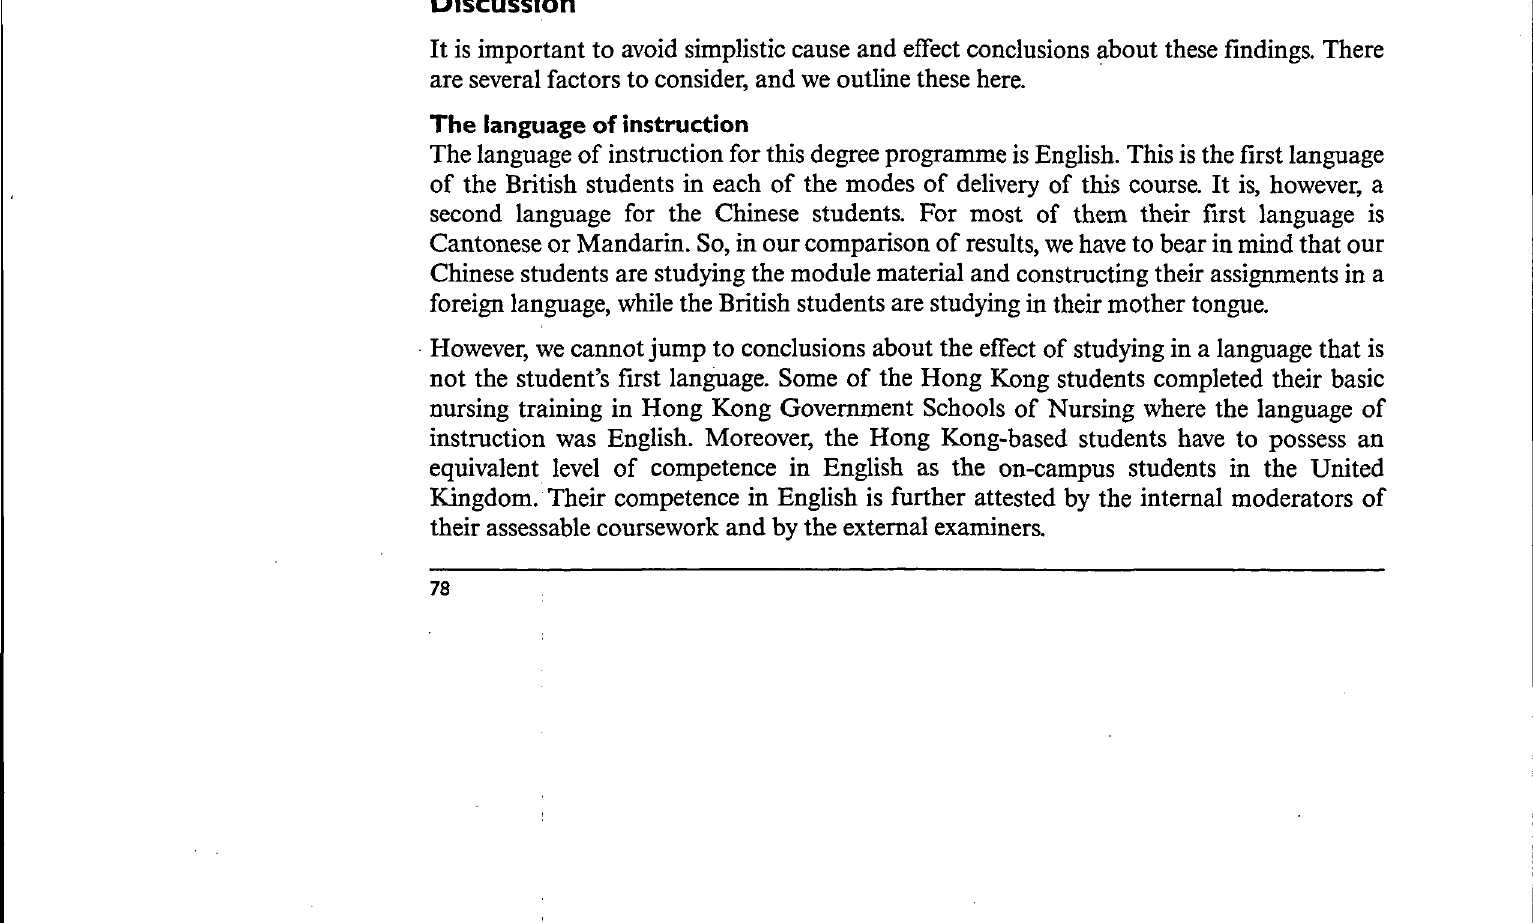
Table 3: Comparisons of the mean scores achieved by the four groups of students, using Kruskal-Wallis.